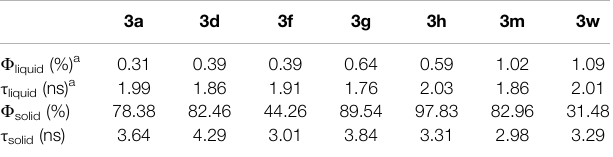
TABLE 3 | Luminescence quantum yield and lifetime of selected